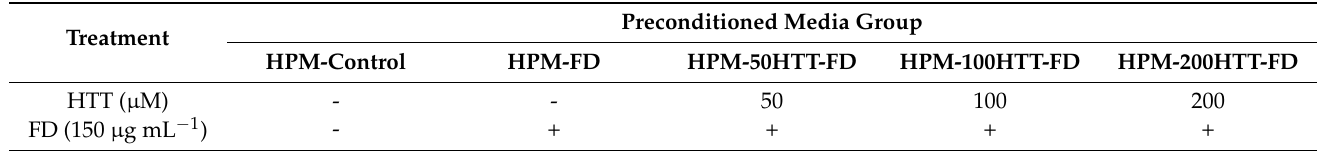
Table 1. Abbreviations used for denoting preconditioned media groups.